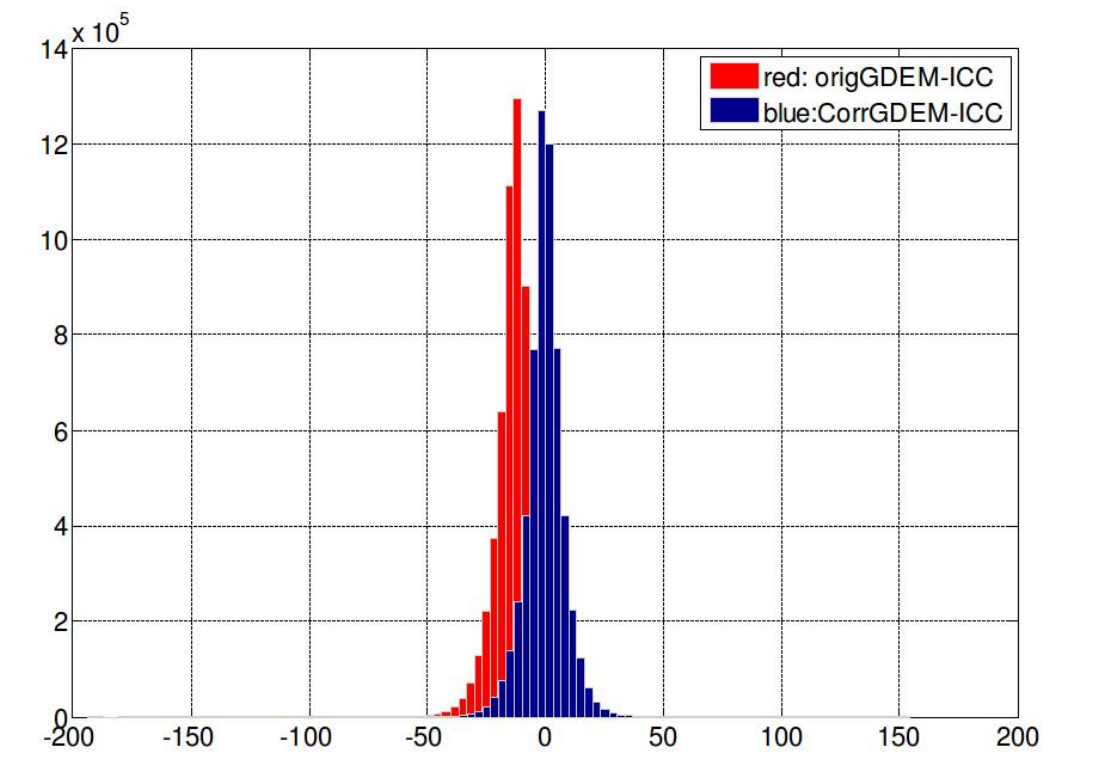
Figure 19. Histograms displaying the differences between original ASTER GDEM and ICC ground truth (red) as well as the differences between corrected ASTER GDEM and ICC ground truth.